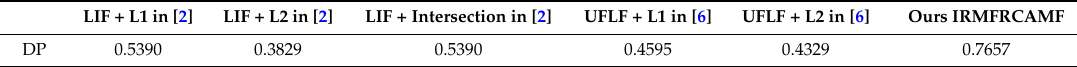
Table 8. Dataset-level precision (DP) under different methods.